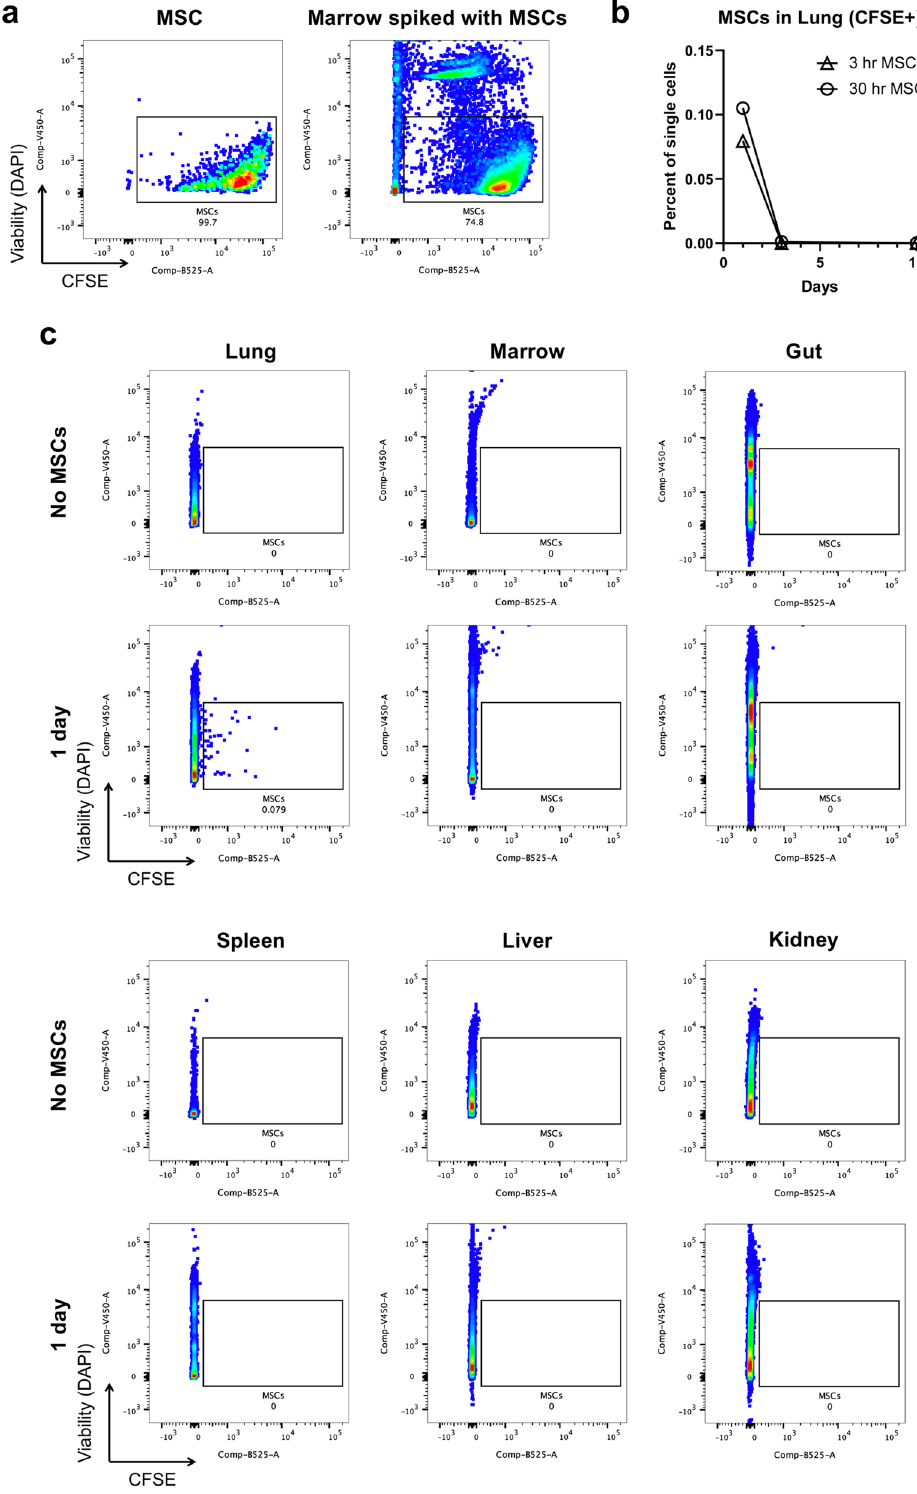
Figure 8. Human MSCs lodge in the lung and are undetectable in other organs. ( a ) CFSE-labeled human MSCs are detectable by flow cytometry when spiked into unlabeled bone marrow. ( b ) Lung was the only organ in which CFSE + MSCs could be detected 1 and 3 days after infusion. This distribution occurred for administration of MSCs at 3 h and 30 h after irradiation. ( c ) Representative flow plots are depicted for all organs